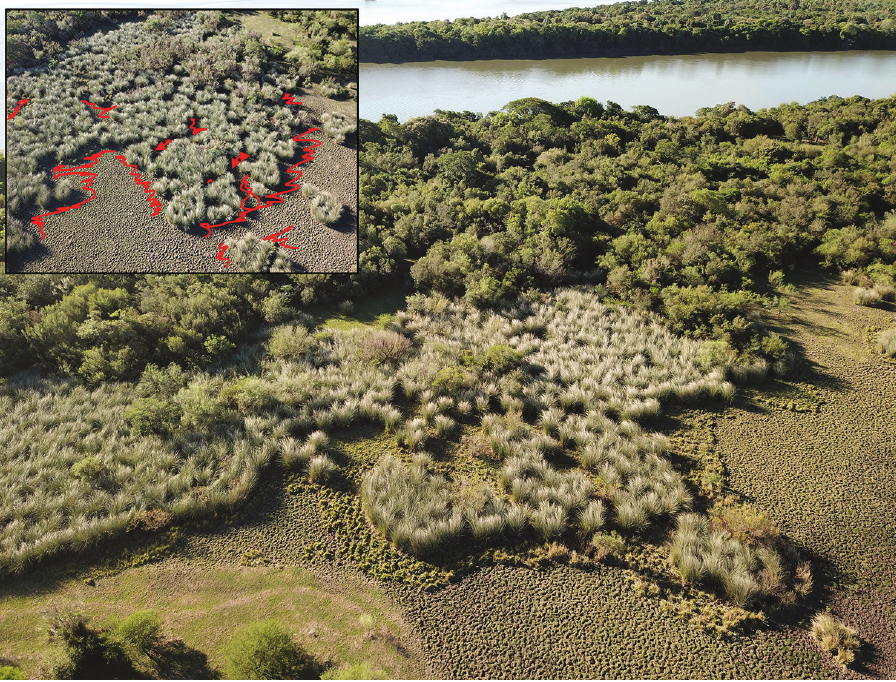
Figure 1. Habitat of Vernonia incana and V. echioides taken with a drone at the Environmental Protection Area Rincon de Franquía , Cuareim River, Artigas, Uruguay: insert shows in red the areas where the semi- aquatic Vernonias of South America can be found. (photos by J.M. Bonifacino,